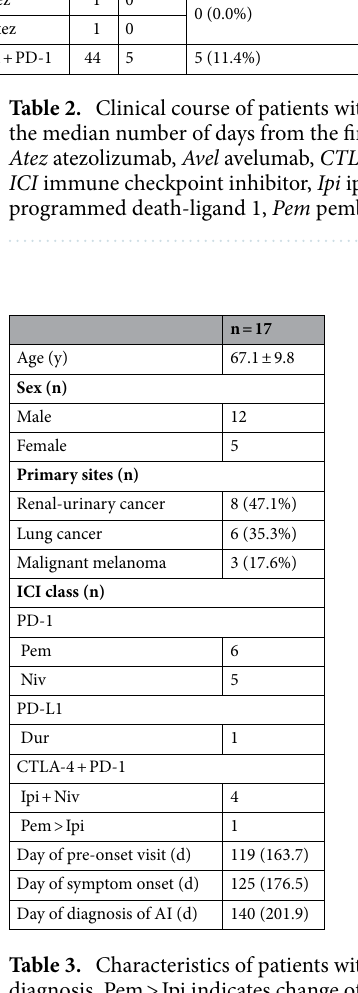
(median/average: 1.8/2.0 at baseline, 4.1/5.8 at pre-onset, and 7.0%/7.6% at AI) and serum creatinine (median/ average: 0.8/0.9 at baseline, 0.9/1.1 at pre-onset, and 0.9/1.4 mg/dL at AI) had increased even by pre-onset, whereas this was not the case for the other factors (Fig. 1).